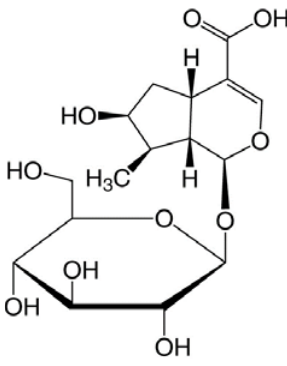
Figure 2. Chemical structure of loganic acid.